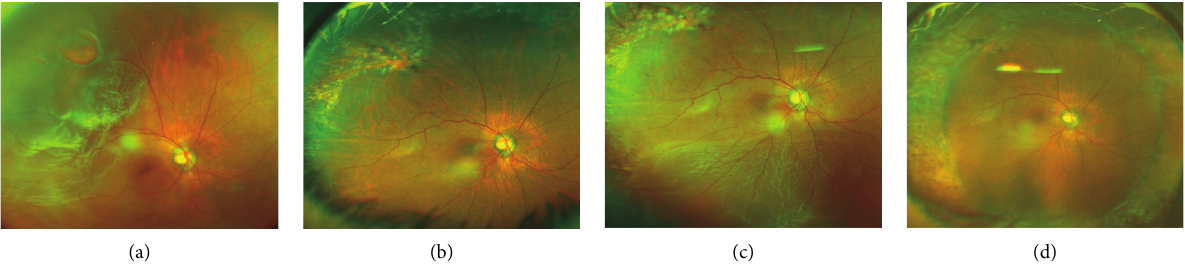
Figure 1: Findings in a 71-year-old Japanese woman with a recurrent rhegmatogenous retinal detachment after successful attachment by pars plana vitrectomy. She was treated by a second surgery with vitrectomy and encircling scleral buckling. (a) Ultra-wide-field fundus image showing a retinal break at the superotemporal area and rhegmatogenous retinal detachment (RRD). Her best-corrected visual acuity (BCVA) was 20/30. (b) Ultra-wide-field fundus image after the initial surgery showing retinal scar and attached retina. (c) The recurrence of RRD was observed at 2 weeks after the initial surgery. Ultra-wide-field fundus image shows inferior retinal detachment. The cause of the RRD was a new small break at the inferonasal retina. Her BCVA was 20/60. (d): Ultra-wide-field fundus image after a reoperation by vitrectomy and encircling buckle. Reattached retina and the protrusion of encircling buckle can be seen. Her visual acuity was 20/25 at seven months after the reoperation.